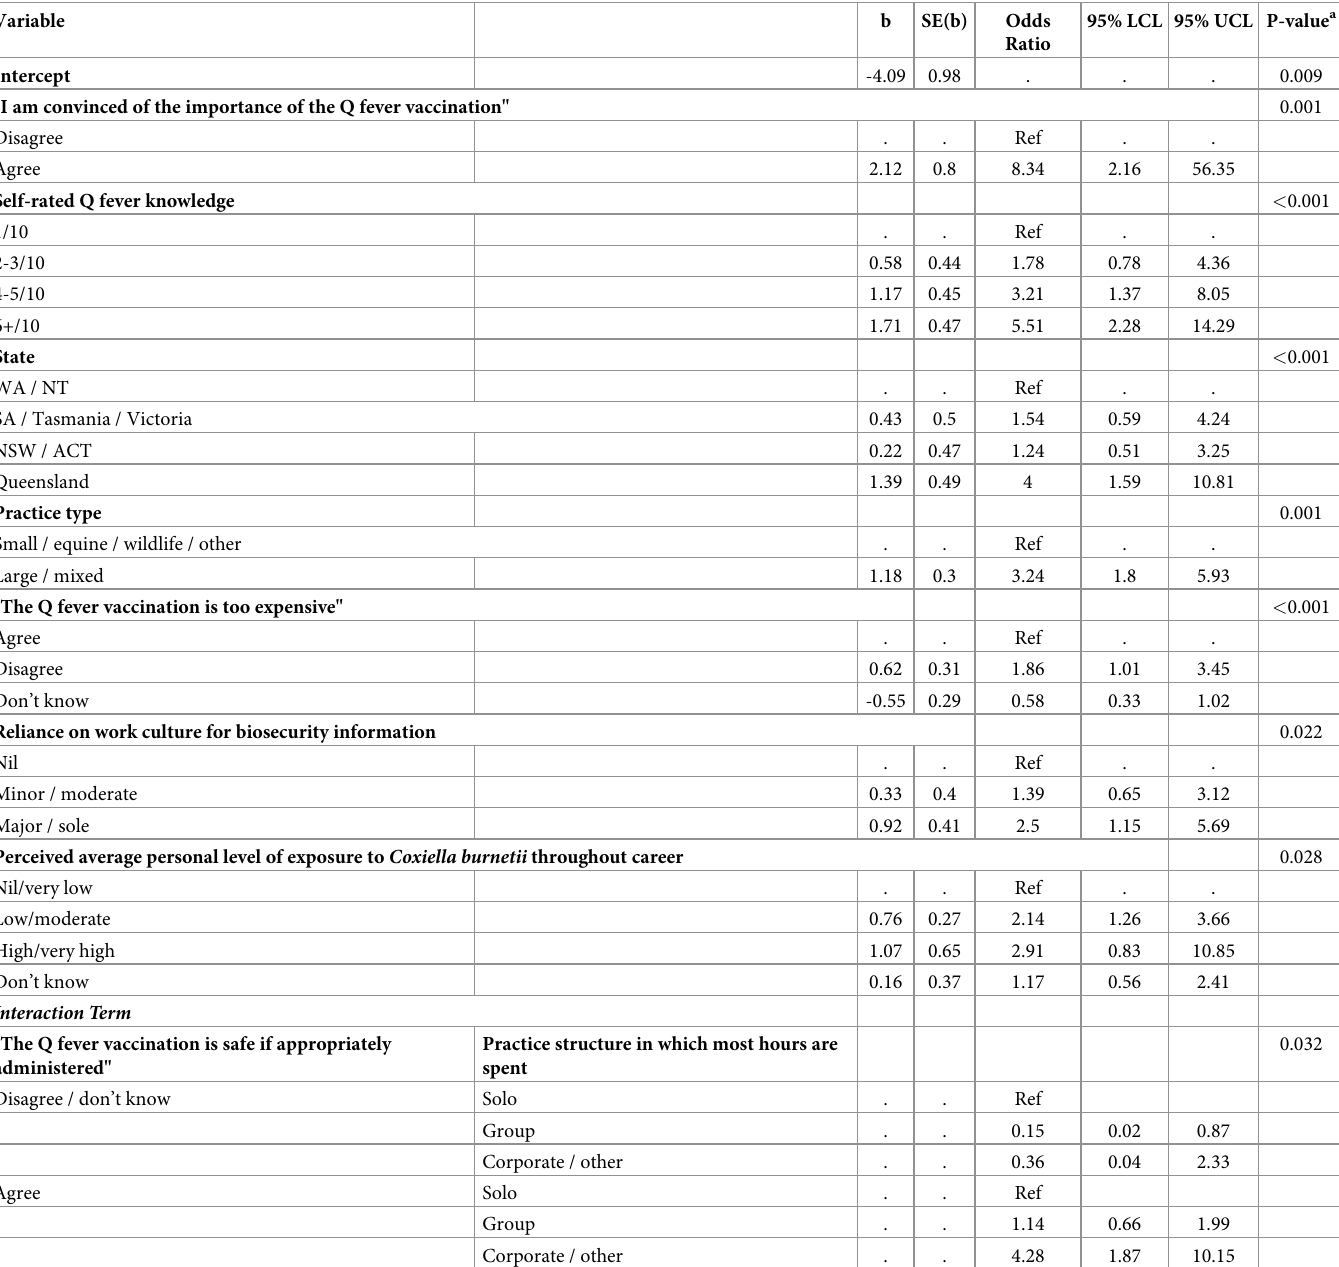
Table 2. Final multivariable model parameter estimates and odds ratios of factors significantly associated with Q fever vaccination status of veterinary nurses in Australia in